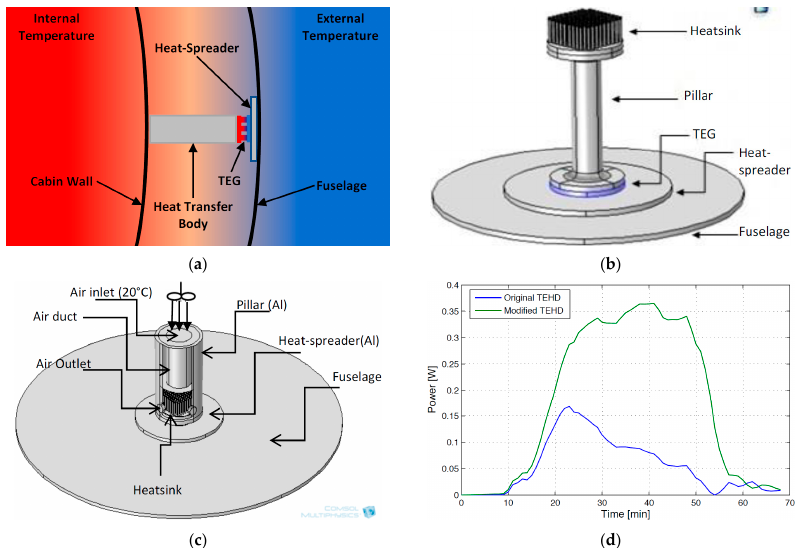
Figure 27. Scheme of the TEG mounting on the fuselage ( a ), initial harvester design ( b ), modified harvester design ( c ) and output power obtained for both design configurations ( d ) [162].